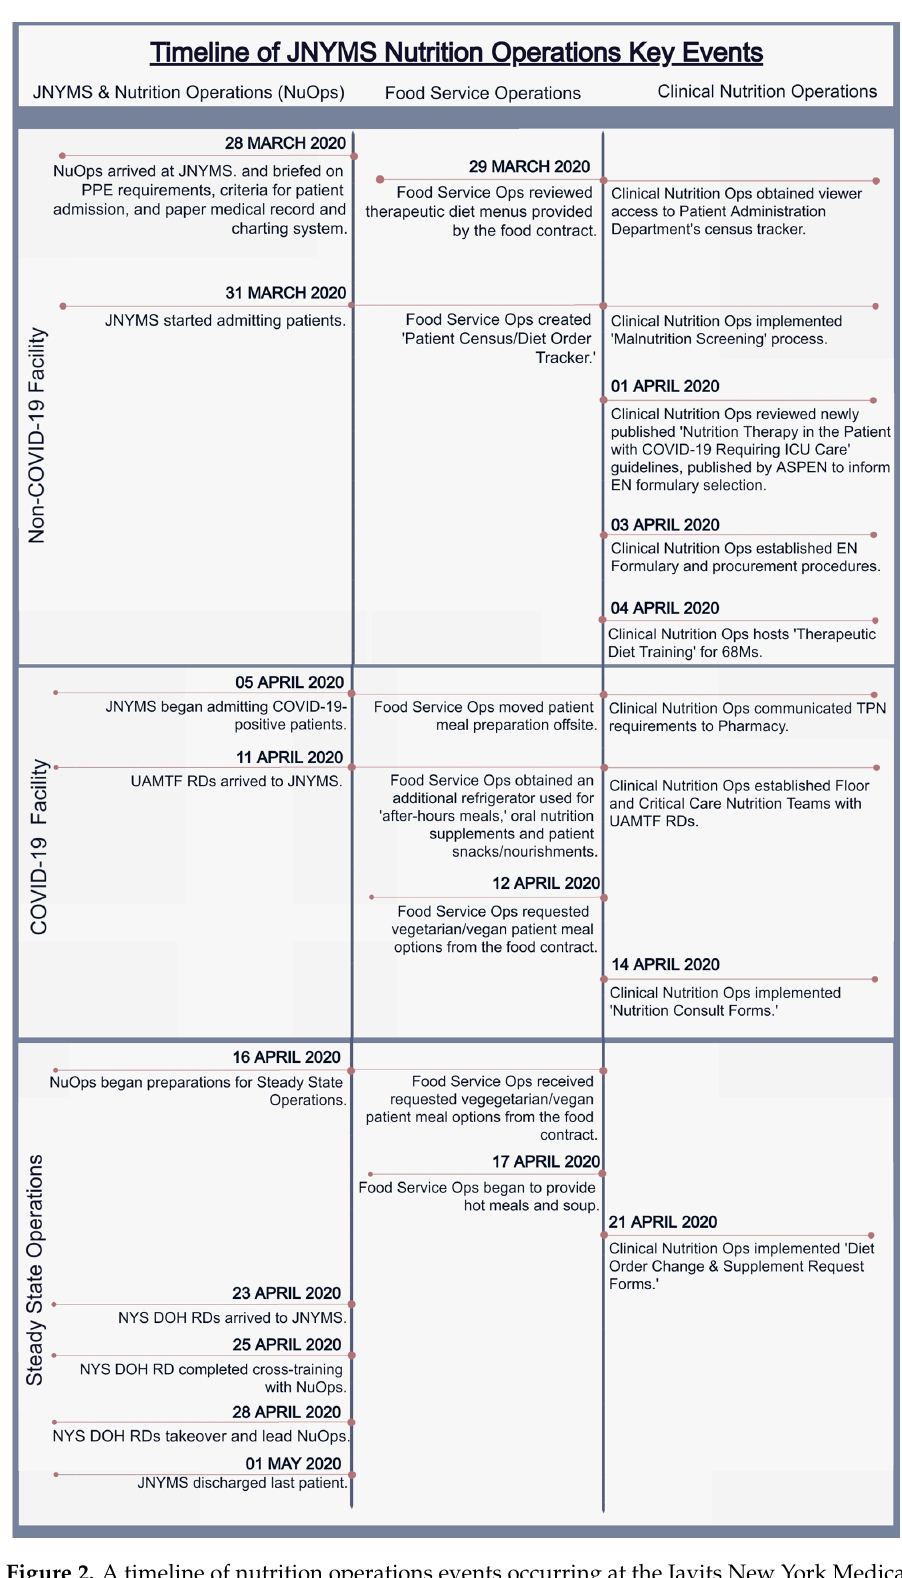
Figure 2. A timeline of nutrition operations events occurring at the Javits New York Medical Station (JNYMS) field hospital in New York City. This timeline includes JNYMS and NuOp personnel operations, food service operations, and clinical nutrition operations from NuOp personnel arrival on 28 March through the JNYMS discharging its last patient on 1 May.